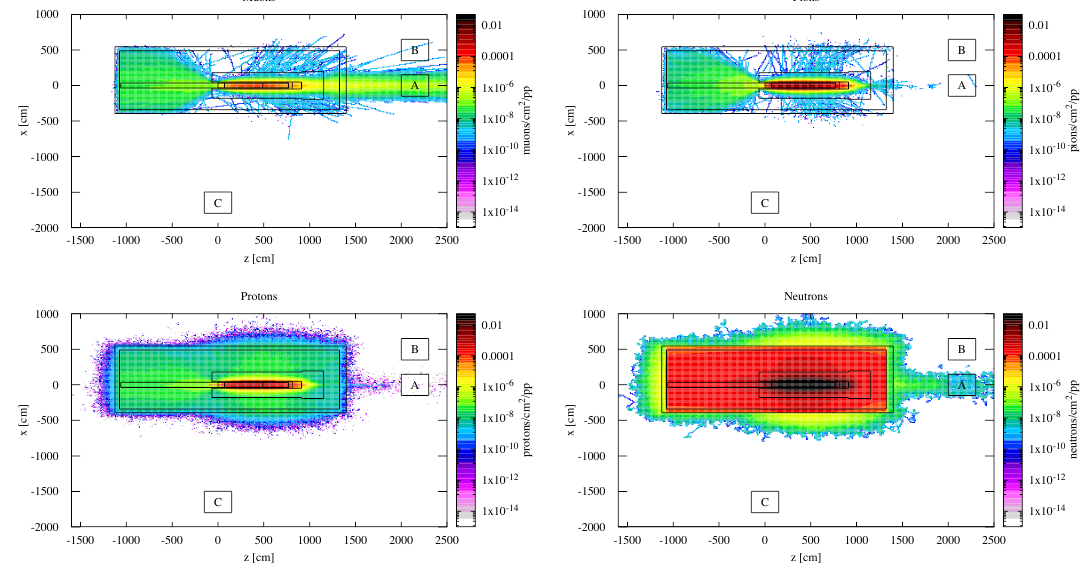
Figure 4. Fluence of background particles: muons (top left), pions (top right), protons (bottom left) and neutrons (bottom